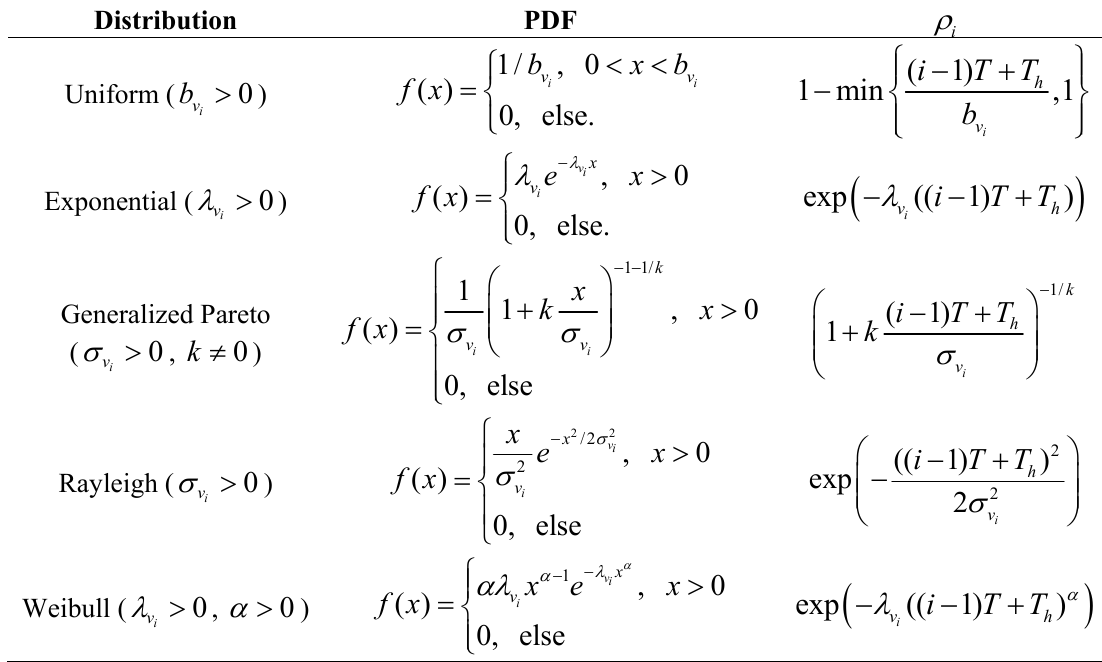
Table 1. Distributions of the time duration during which a channel remains